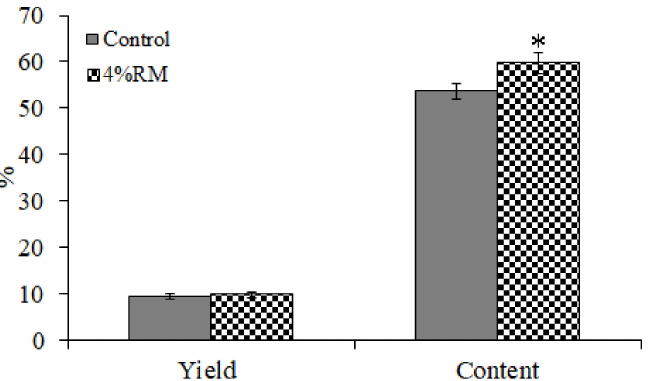
Figure 5. Yields and contents of crude polysaccharides extracted from the P. ostreatus mycelium grown on potato dextrose agar (PDA) (%, dry weight basis). * indicates a significant difference at p < 0.05 compared with the control group.